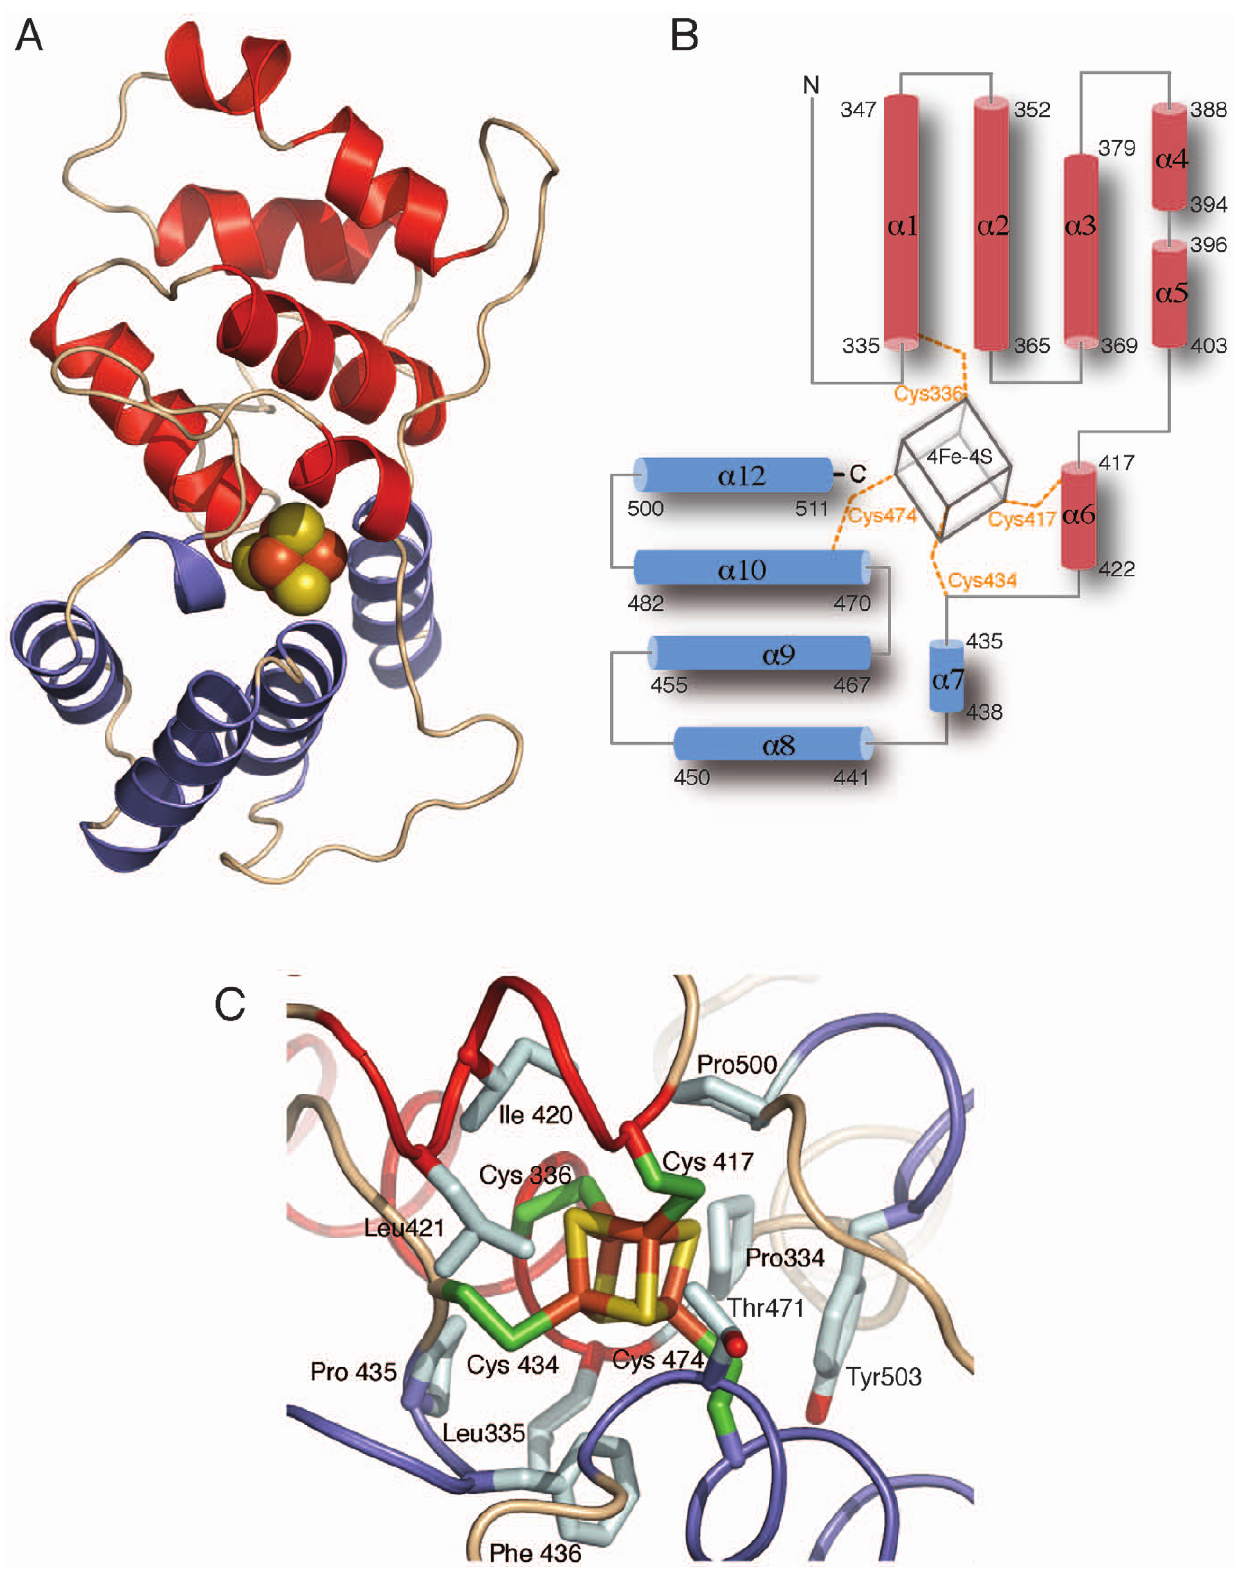
Figure 1. Crystal structure of yeast PriL-CTD at 1.55 A˚. ( A ) Ribbon diagram of the PriL-CTD. The larger N-terminal domain is coloured in red and the smaller C-terminal domain in blue. The Fe-S cluster cofactor is shown in space-fill representation; the Fe and S atoms are in red and yellow, respectively. ( B ) Topology diagram of the PriL-CTD; the numbering and residue span of each alpha helix is indicated. The cysteine residues that ligate the Fe-S cluster are explicitly indicated. Colouring as in panel (A). ( C ) Close-up view of the Fe-S cluster. Hydrophobic residues surrounding the Fe-S cluster are shown. The main-chain trace of the PriL-CTD is shown as a thin tube, whereas the Fe-S cluster and side chains are drawn as sticks. doi:10.1371/journal.pone.0010083.g001 PLoS ONE |